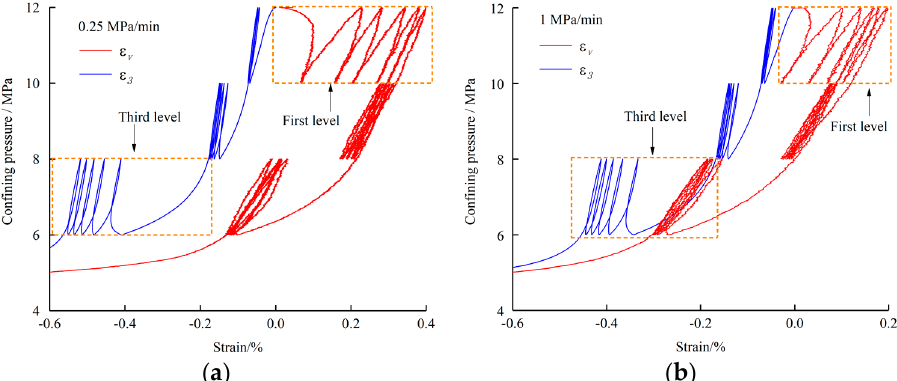
Figure 5. Circumferential and volumetric strain of cyclic unloading condition: ( a ) C-1; ( b ) C-2. Path II: